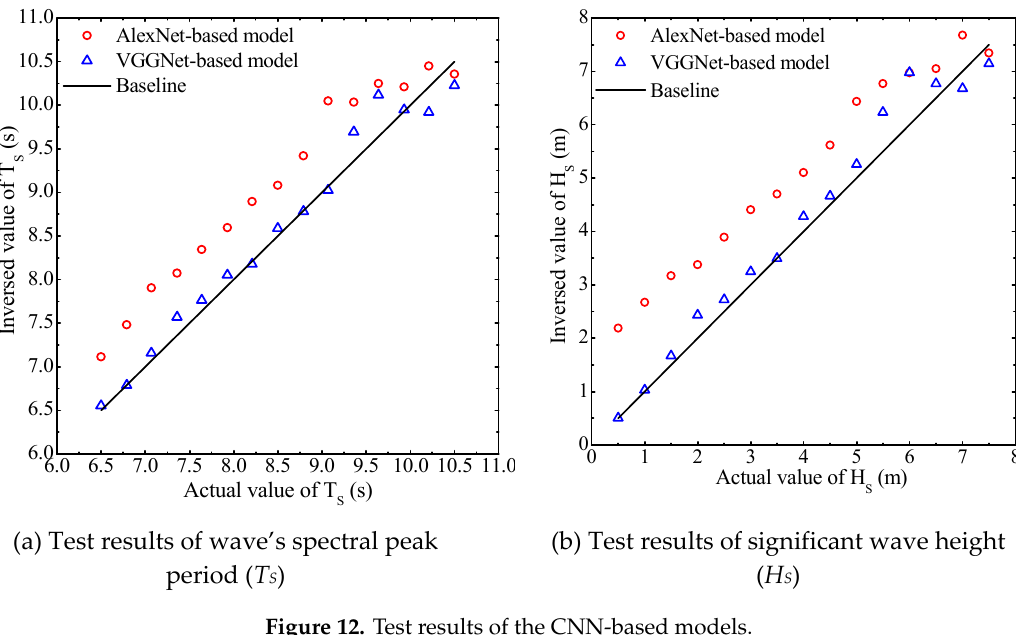
Figure 12. Test results of the CNN-based models. Table 7. Inversion errors of wave’s spectral peak period ( T S ) and significant wave height ( H S ) by CNN- based models.